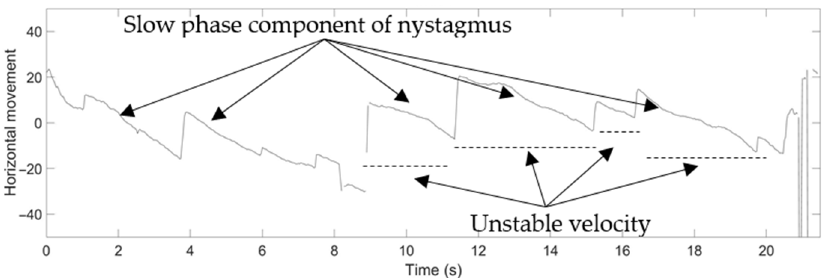
Figure 13. Nystagmus waveform from the proposed method for Video No. 1, horizontal movement of the pupil.